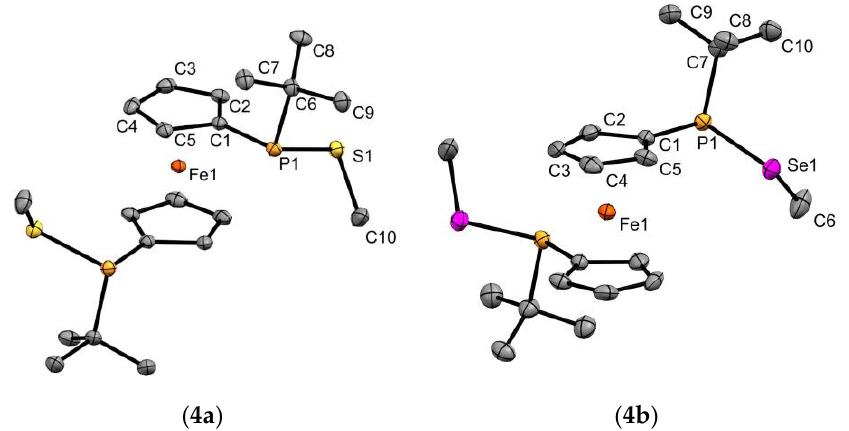
Figure 2. Molecular structure of 4a (left) and 4b (right) in solid state. Ellipsoids are shown at 30% probability, and all hydrogen atoms have been omitted for better overview. The phosphorus and selenium atoms in 4b showed a small disor- der (ca. 7%) over two positions, which is not shown in the figure. Selected bond lengths and angles of 4a : S1-P1 2.1119(13) Å, ΣP1 = 302.31(13)° and 4b : Se1-P1 2.2581(17) Å, ΣP1 = 303.30(20)°.